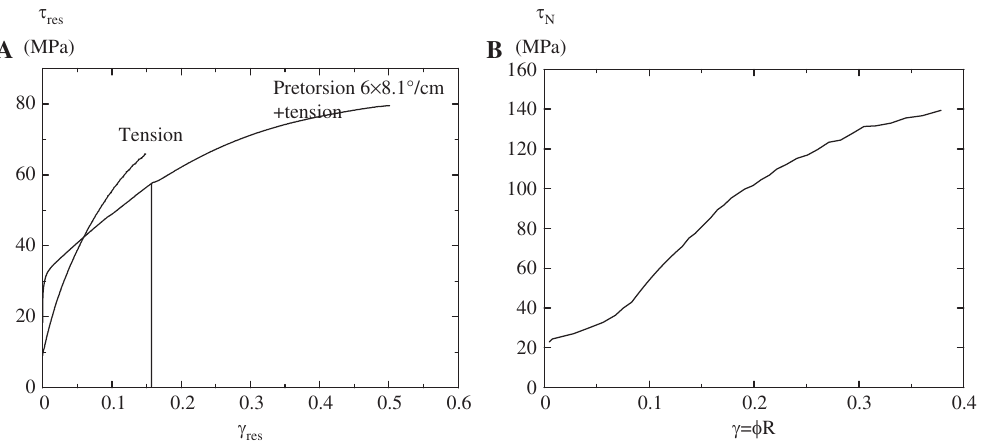
Figure 2 (A) Typical τ -vs.- γ curves in tension and torsion-tension of < 100 > single crystals for series 1 (Cu-1.51 wt % Mn) specimens. The res res vertical line at a strain of γ = 0.16 corresponds to unloading and reloading of the specimen. (B) Applied shear stress τ strain γ in simple torsion of < 100 > single crystals for series 2 (Cu-1.35 wt % Mn)